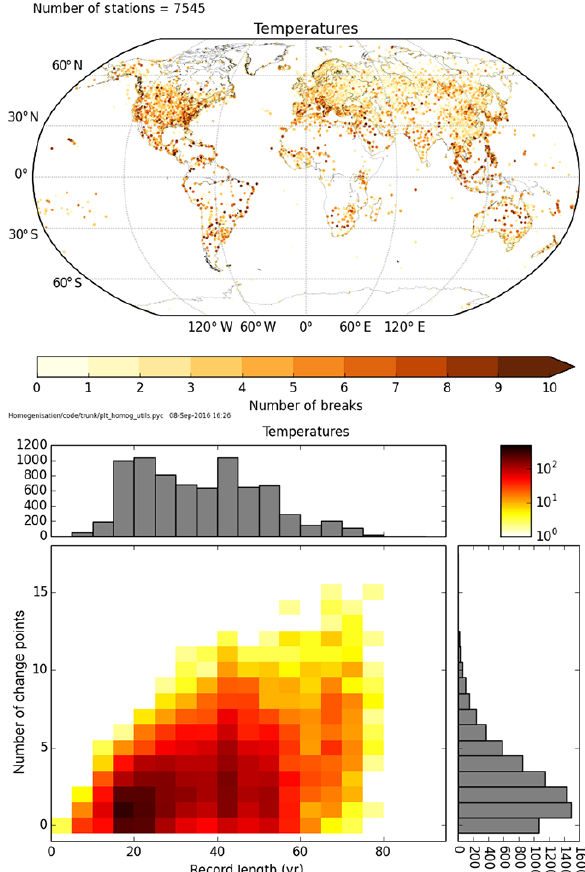
Figure 8. Top panel: the number of change points detected for each station. Bottom panel: the distribution of stations with numbers of change points and record length. Histograms show the distribution of stations with record length (above) and with change point number (right), which are the projections onto the x and y axes of the main panel respectively. The colour bar (top right) is on a logarithmic